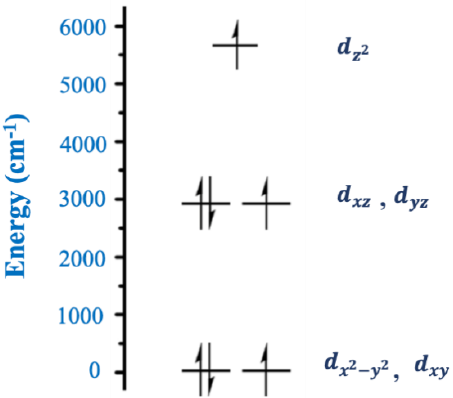
Figure 12. Energy diagram and occupations of the 3d orbitals by electrons in the linear complex 16 . Modified from reference [101].